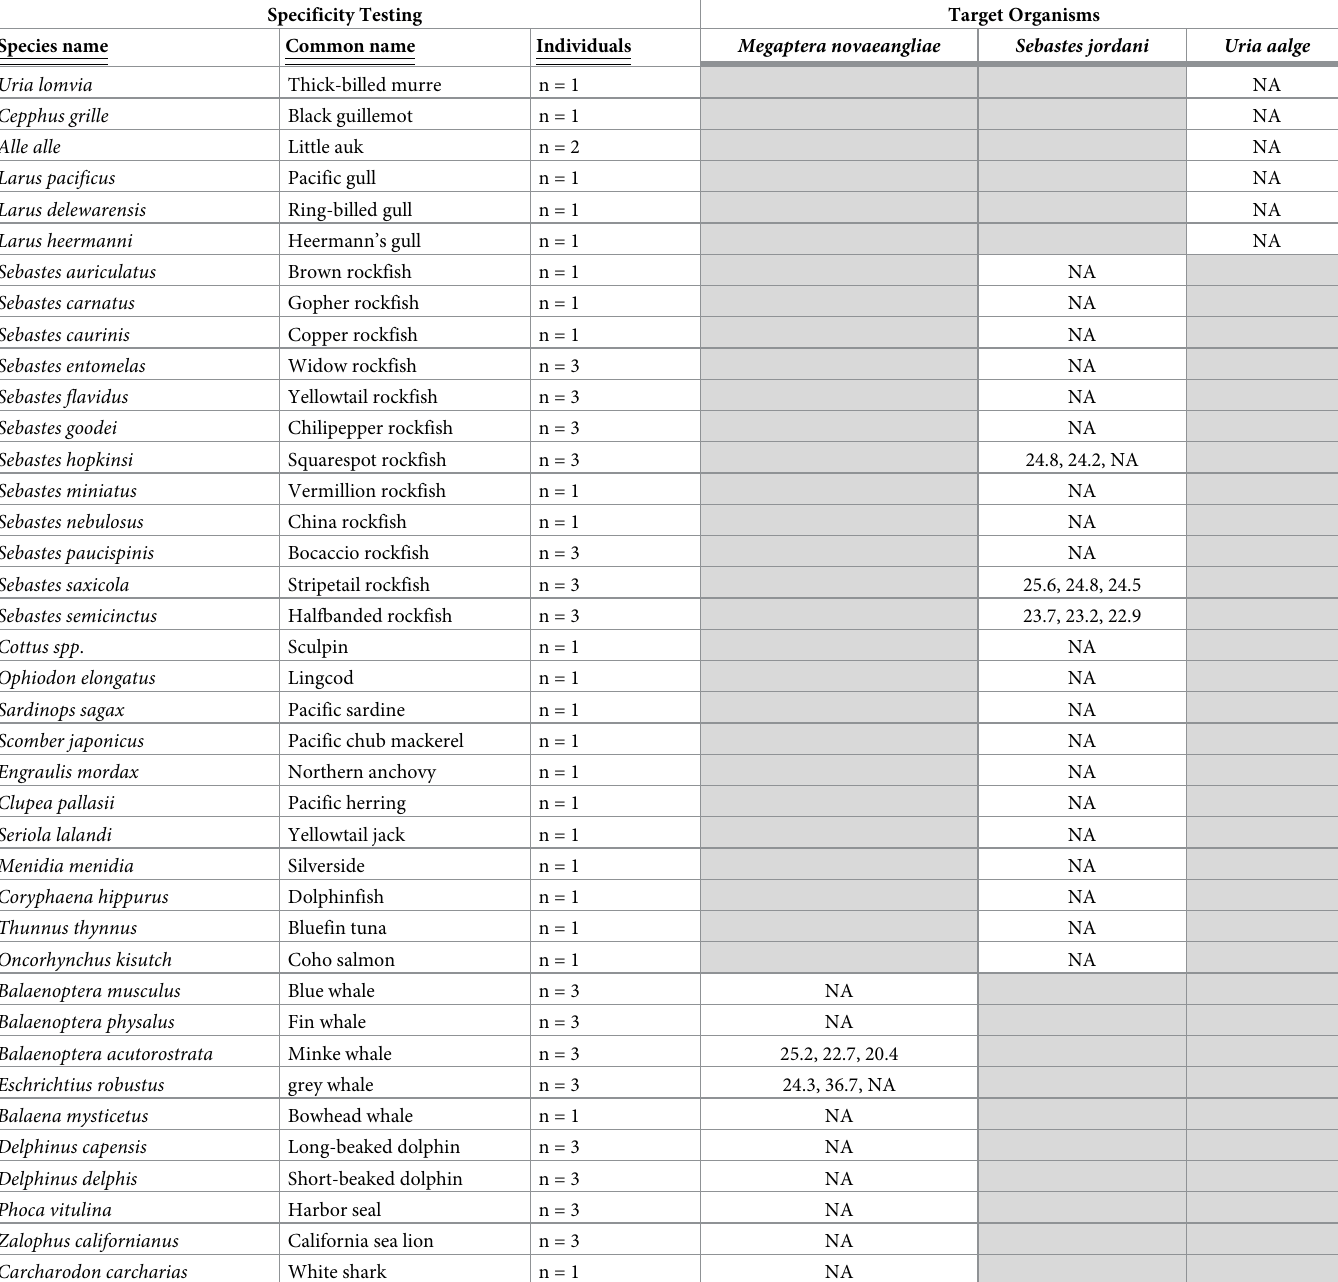
Table 4. Results of in vivo specificity testing. The three target organisms are shown on the right. Grey shading indicates that the assay was not tested for specificity using the organism on in the first column. “NA” indicates no amplification (i.e., assay is specific). For the non-target species that amplified, the C q values are shown for each indi- vidual. 1–2 ng of gDNA was included in each reaction; see Fig 2 for C q values for target individuals. Specificity